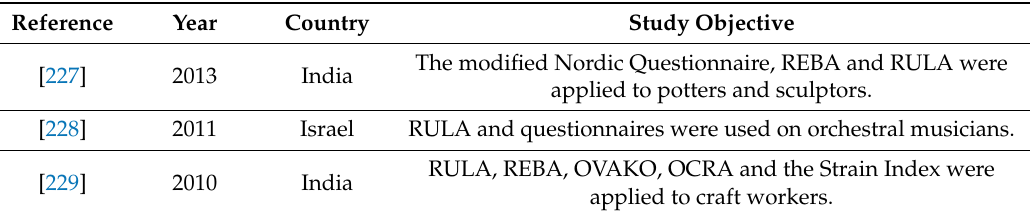
Table 18. Arts, entertainment and recreation.